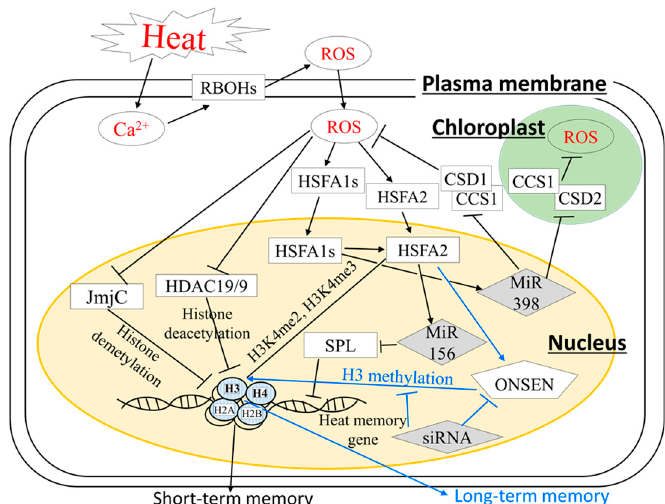
Figure 3. Simplified model of signaling network underlying heat stress memory. Histone methylation, histone acetylation, and miRNA-dependent signals might be key processes for maintaining high expression levels of heat stress memory genes. These key processes could be modulated by ROS, NO, and Ca 2+ . Rectangles indicate proteins; gray diamonds indicate microRNAs; the pentagon indicates the ONSEN transposon; blue ellipses indicate histones; white ellipses indicate other signaling molecules, e.g., Ca 2+ ions, hormones, ROS, and NO. Pathways regulating short- or long-term memory are indicated with black or blue arrows, respectively. Black arrows indicate positive regulation; T-shaped lines indicate negative regulation; yellow circle indicates the nucleus; green circle indicates the chloroplast. Heat stimuli and key signaling molecules (Ca 2+ , ROS and NO) are indicated in red characters. Names of cellular components are indicated in underlined characters.